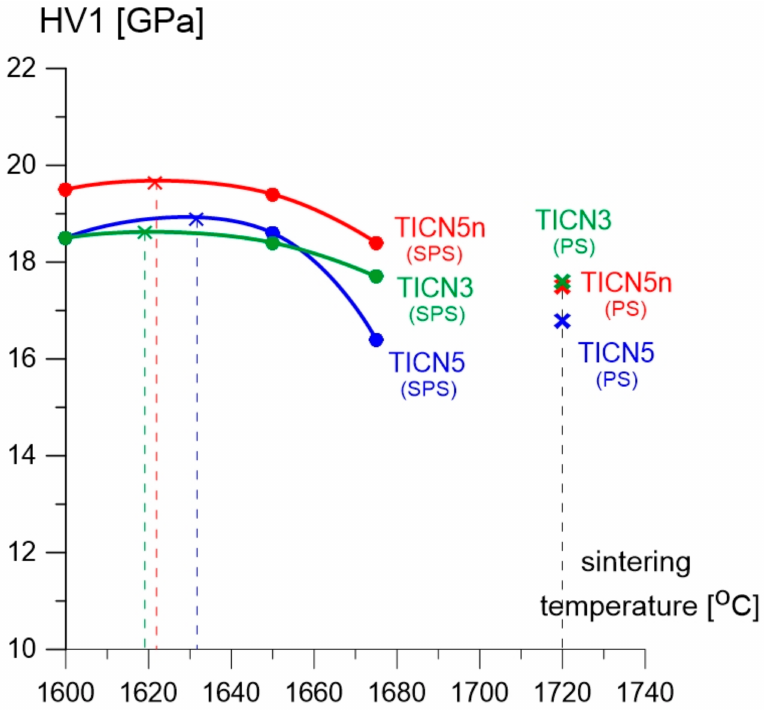
Figure 5. The relationship between Vickers hardness and the temperature of the samples sintered using SPS and PS.